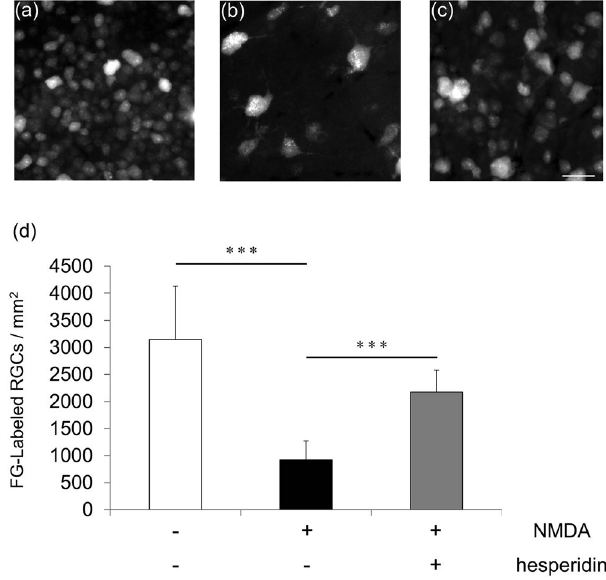
Figure 4. Increase in RGC survival after NMDA injury with hesperidin treatment. Representative images of FG-labeled RGCs 10 days after the intravitreal injection of vehicle ( a ), NMDA ( b ), or NMDA with hesperidin ( c ). Histogram showing the average number of FG-positive cells in each group ( d ). Data represent mean ± SD (vehicle, n = 9; NMDA, n = 8; NMDA/hesperidin, n = 10). *** p < 0.001. Scale bar: 50 µ m.